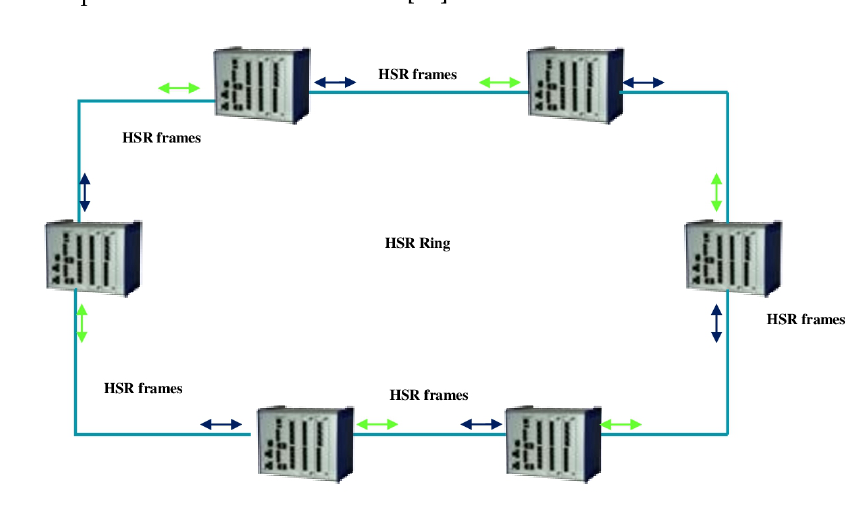
Figure 13. HSR network